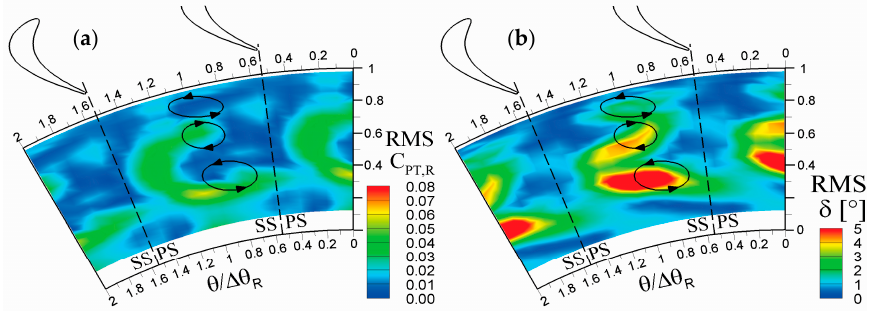
Figure 16. RMS of periodic unsteadiness for OPLL, ( a ) RMS of the relative total pressure coefficient; ( b ) RMS of the deviation angle.